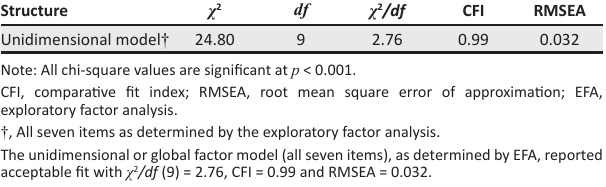
TABLE 6: Confirmatory factor analysis on the unidimensional construct – Servant leadership (all seven original items). Structure